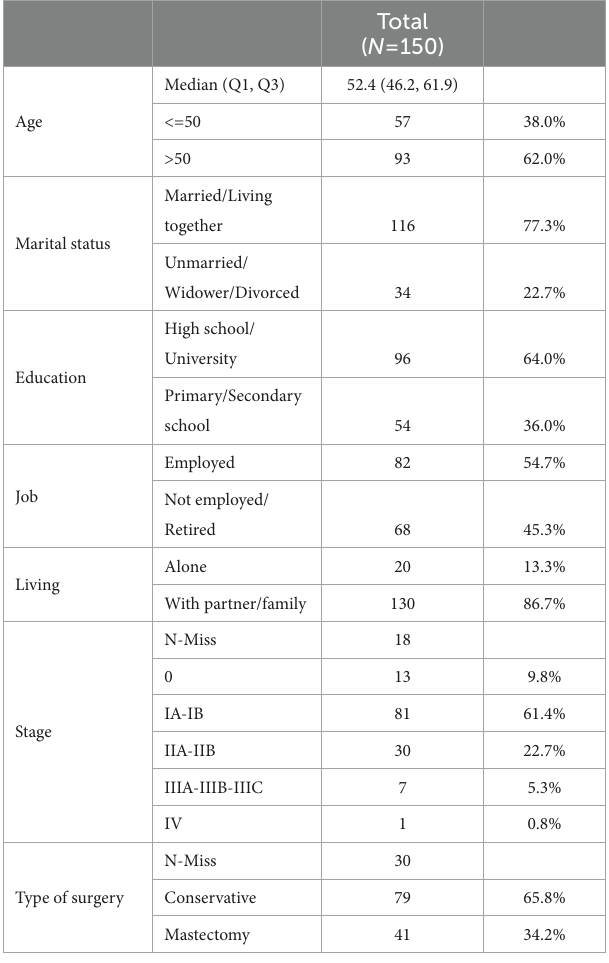
TABLE 1 Demographics and clinical characteristics of patients at enrolment ( N =